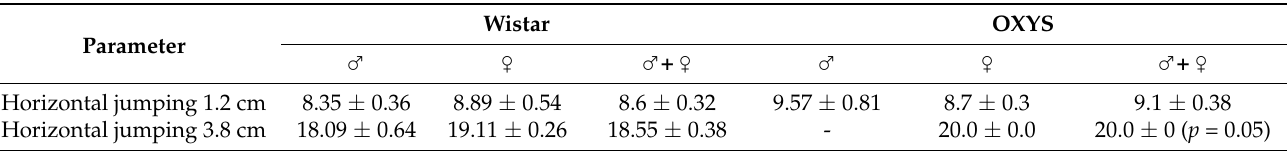
Table 5. The average day of crossing the